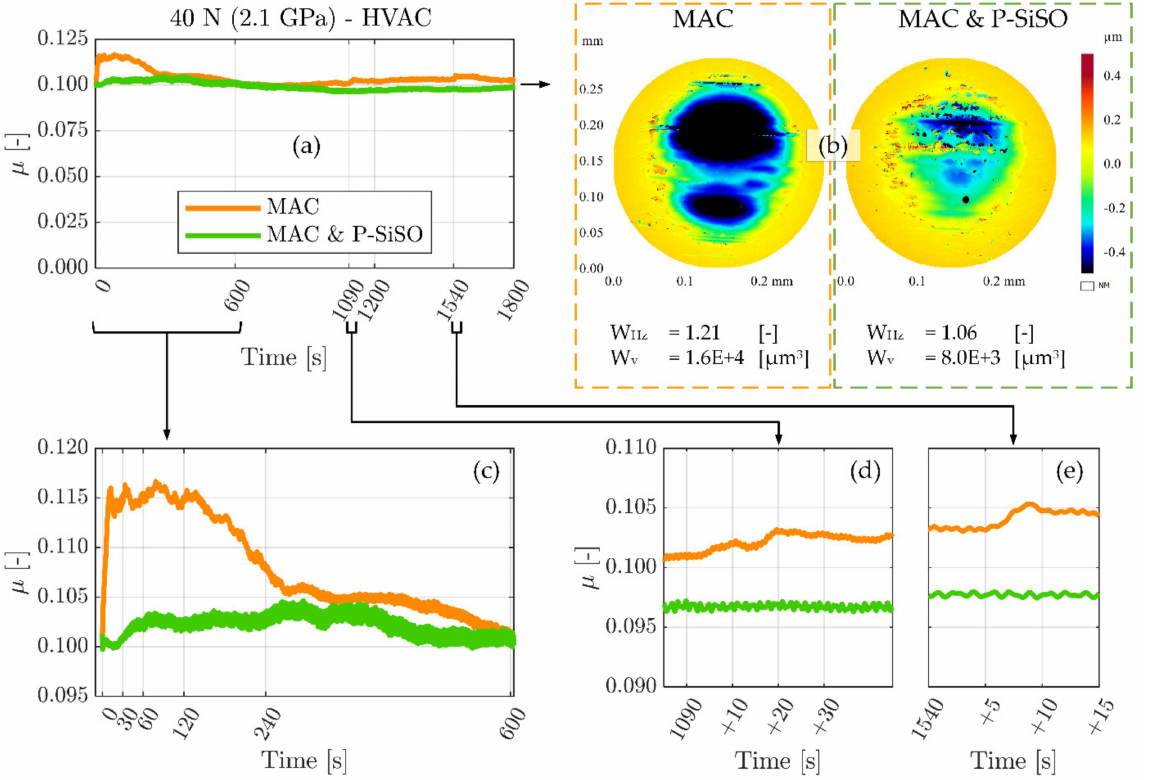
Figure 4. Results from MVT-2 tribotest in high vacuum comparing neat MAC, and 0.4 wt% P-SiSO in MAC, ‘MAC &P-SiSO’. ( a ) Friction traces over 30 min test duration. ( b ) Topographical data (optical 3D-profilometer, 3DP) of the ball wear scars, together with numeric wear indices (W Hz ) and wear volumes (W v ). ( c ) Detailed view of the running-in period. ( d , e ) detailed views of abrupt friction increase interpreted as indication of partial